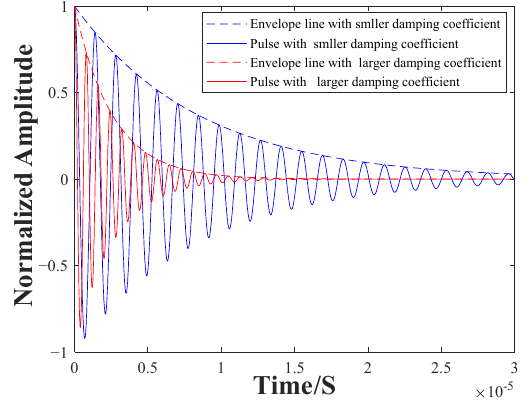
Figure 4. Simulation results of equivalent circuit model.